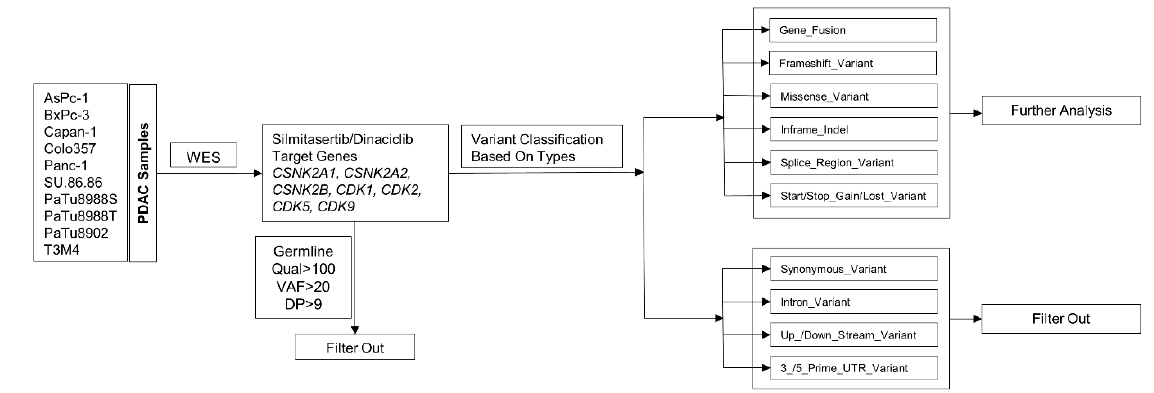
Figure 7. Filtering strategy of inhibitor target genes.